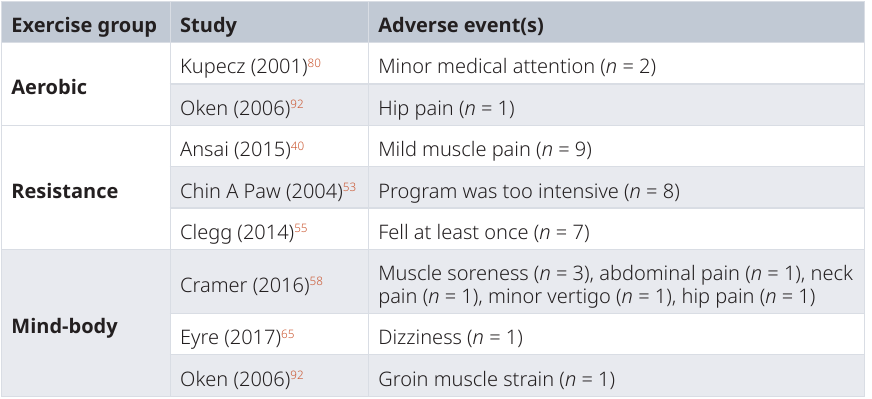
comparison (aerobic vs. resistance vs. mind-body). No